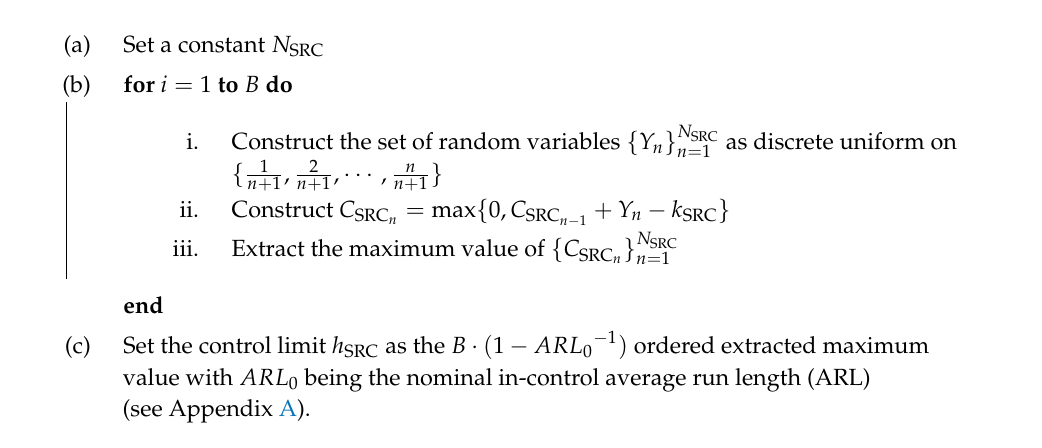
Algorithm 1: Calculate h SRC for fixed k